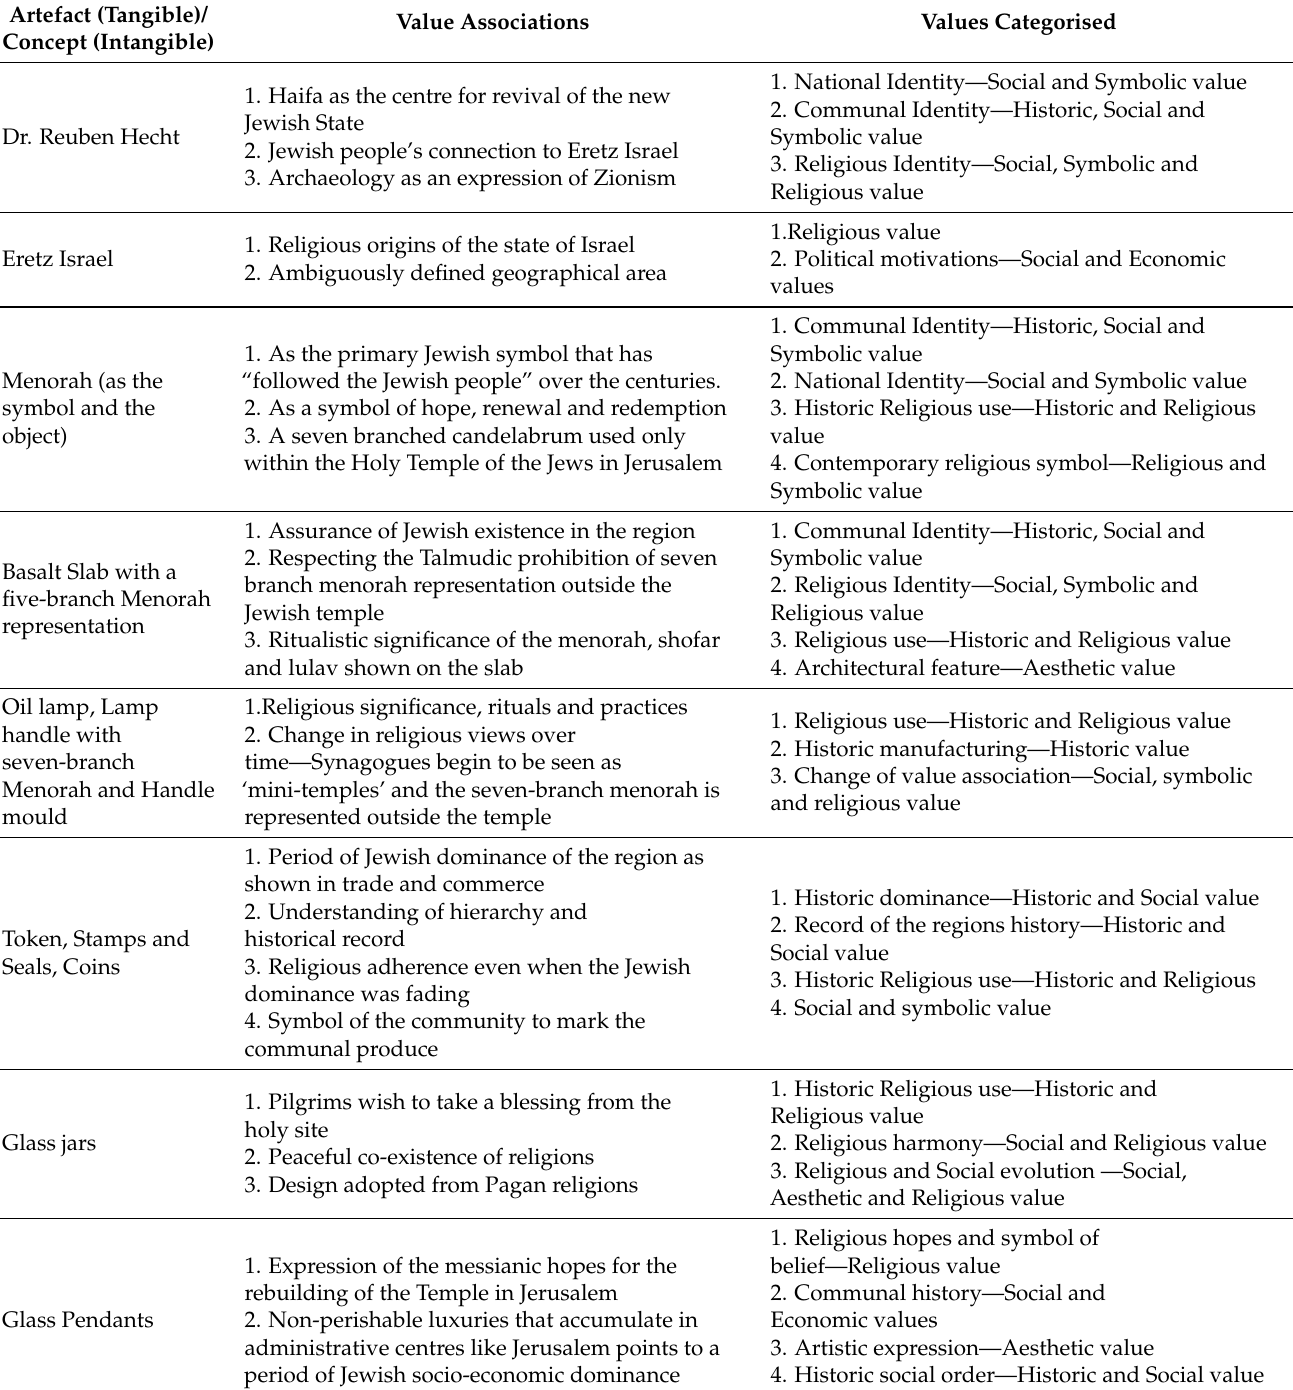
Table 2. Concepts and artefacts that form a part of the Menorah collection and their associated values along with a broad value typology based categorisation resulting from the previous